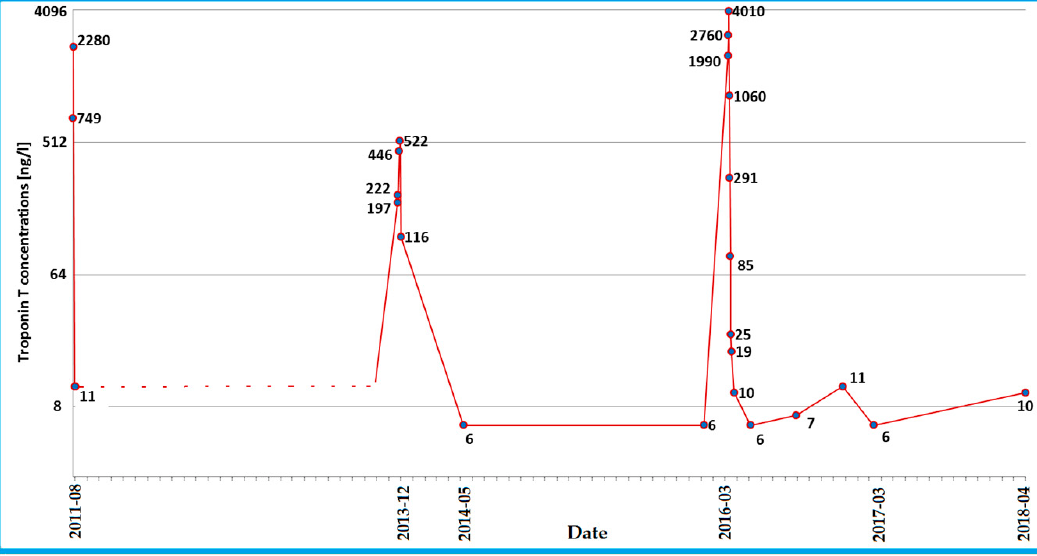
Figure 1. Changes in the troponin T concentration, reflecting the course of the DSP cardiomyopathy with recurrent acute myocardial injury. A dotted line was used where no measurements were available to recreate the course of the variable.